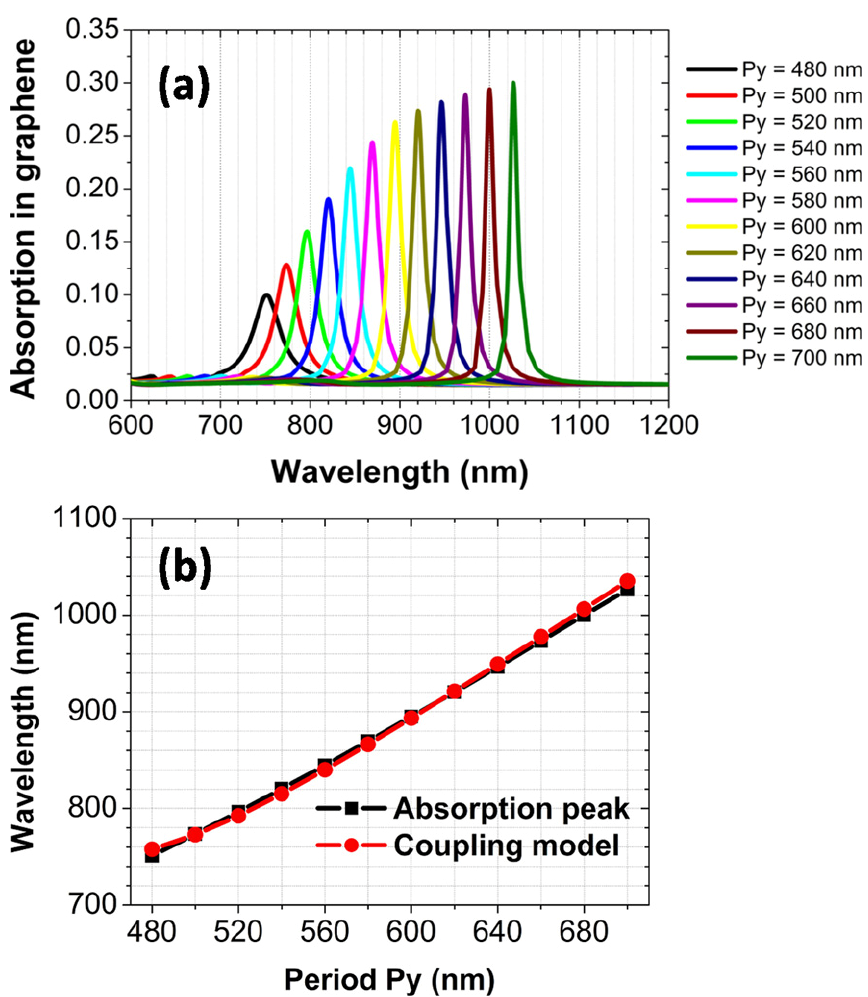
Figure 4. ( a ) The absorption spectra of the graphene monolayer for the different array periods p y . ( b ) The dependence of the absorption peak on the array period p y .